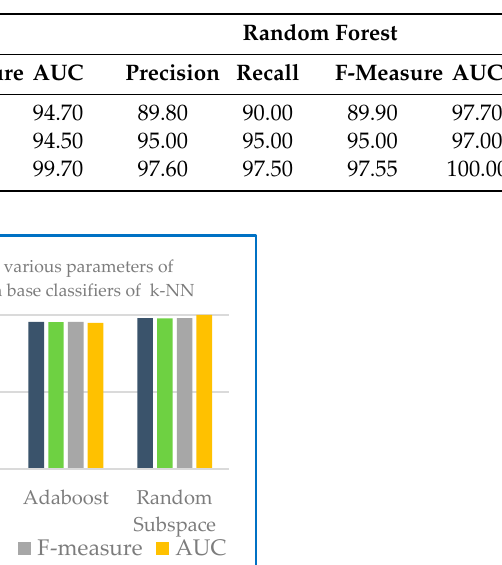
Table 1. Performance measures with base classifiers of k-NN and RF on 10-fold cross-validation method.